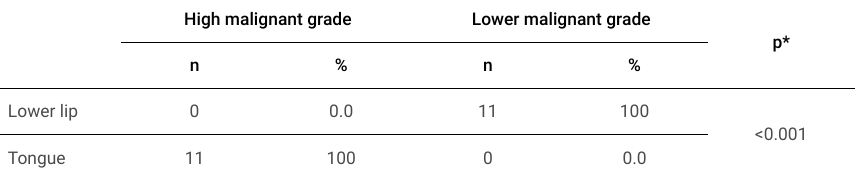
Table 2. Malignancy grading of the squamous cell carcinomas of the lower lip and tongue. High malignant